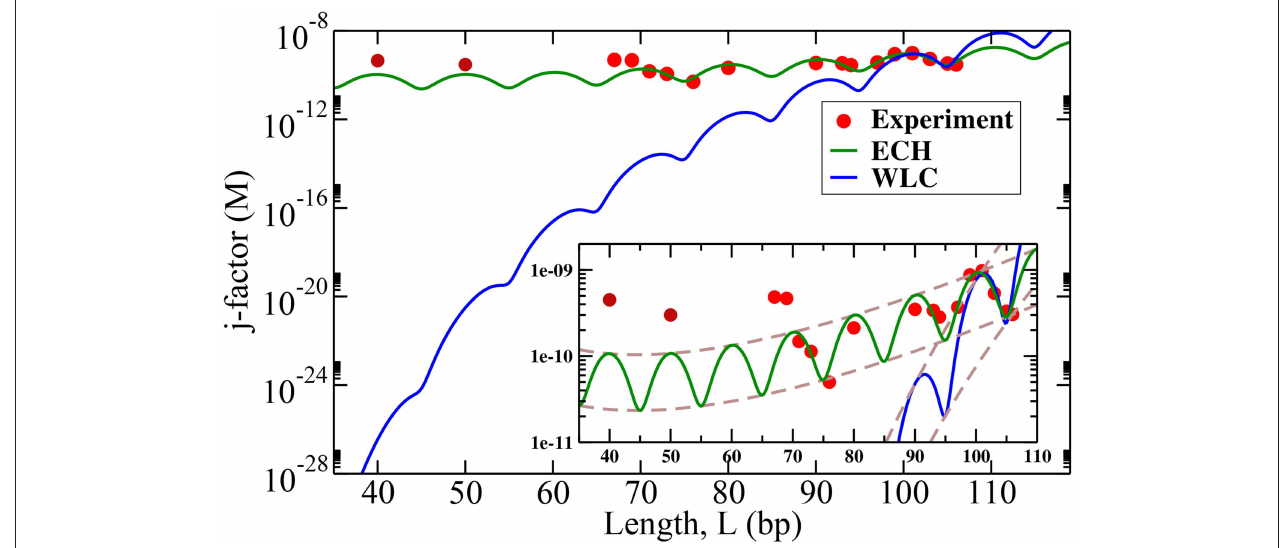
FIGURE 5 | DNA cyclization j-factors computed using the proposed ECH model (green line) and WLC (blue line) are compared with recent experiment [19] (red dots, L > 60 bp). Experimental values of persistence length, L p = 150 bp and θ a = 2.2 ◦ ( Figure 4 ) were used; the value of k in Equation (6) was obtained independently for each model as best fit against two experimental data points for fragment length L = 101 and 106 bp (see Supplementary Material ). The envelopes of the j-factor (brown dashed lines) for ECH and WLC are shown in the inset. Predicted envelope for ECH j-factor has a minimum near 45 bp. The experimental data points L = 50 and L = 40 bp were shared by Taekjip Ha (see reference [ 19]) in private communication to assess model performance after the model had been constructed.